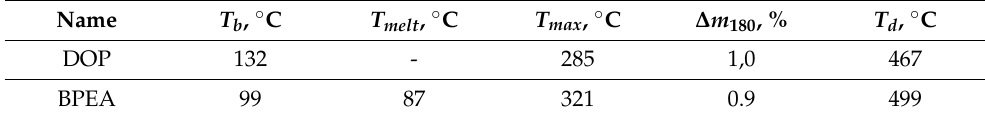
Table 3. Results of thermogravimetric analysis of plasticizer.